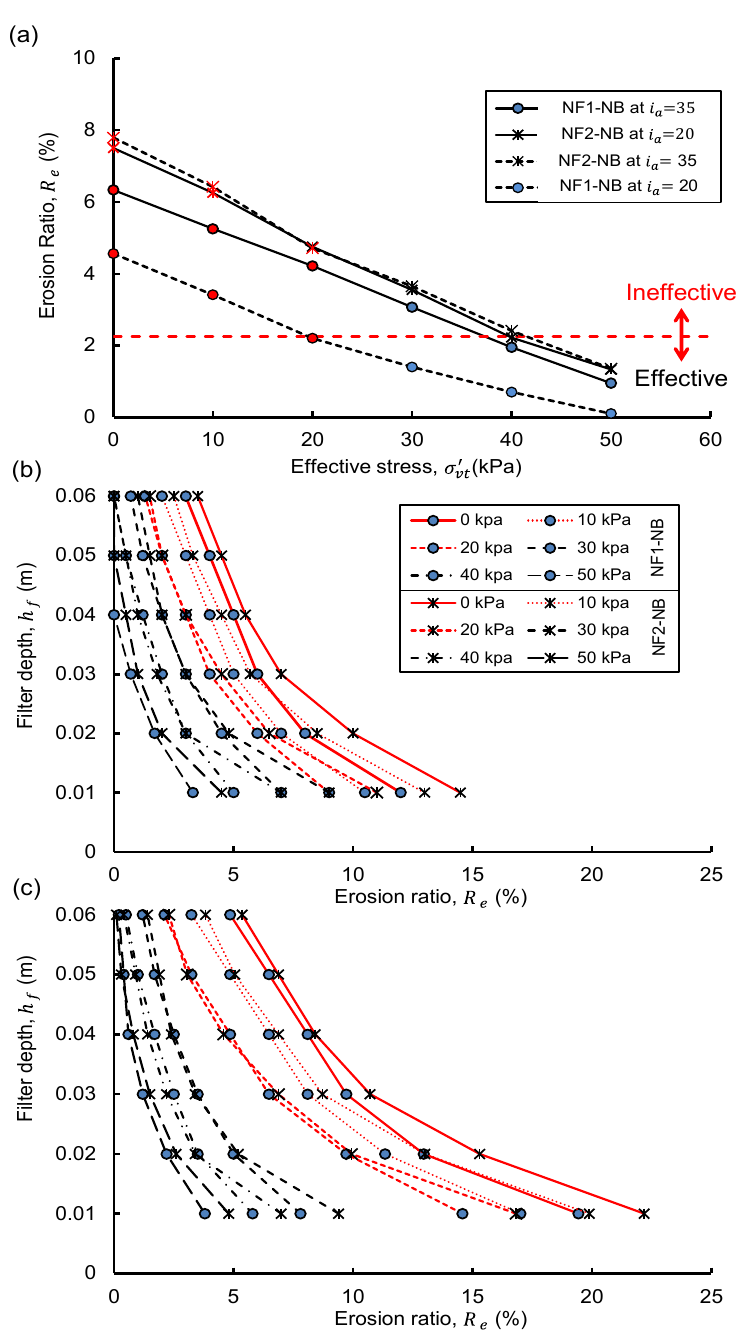
Figure 5. ( a ) Observed relationship between erosion ratio R e and effective stress magnitude in base soil, ( b ) spatial distributions of particles eroded and captured at various depths within the filter medium at t = 0.2 s, and ( c ) spatial distributions of particles eroded and captured at various depths within the filter medium at t = 0.3 s. ( Note: Red lines in Figures 5b and 5c represent ineffective filters).